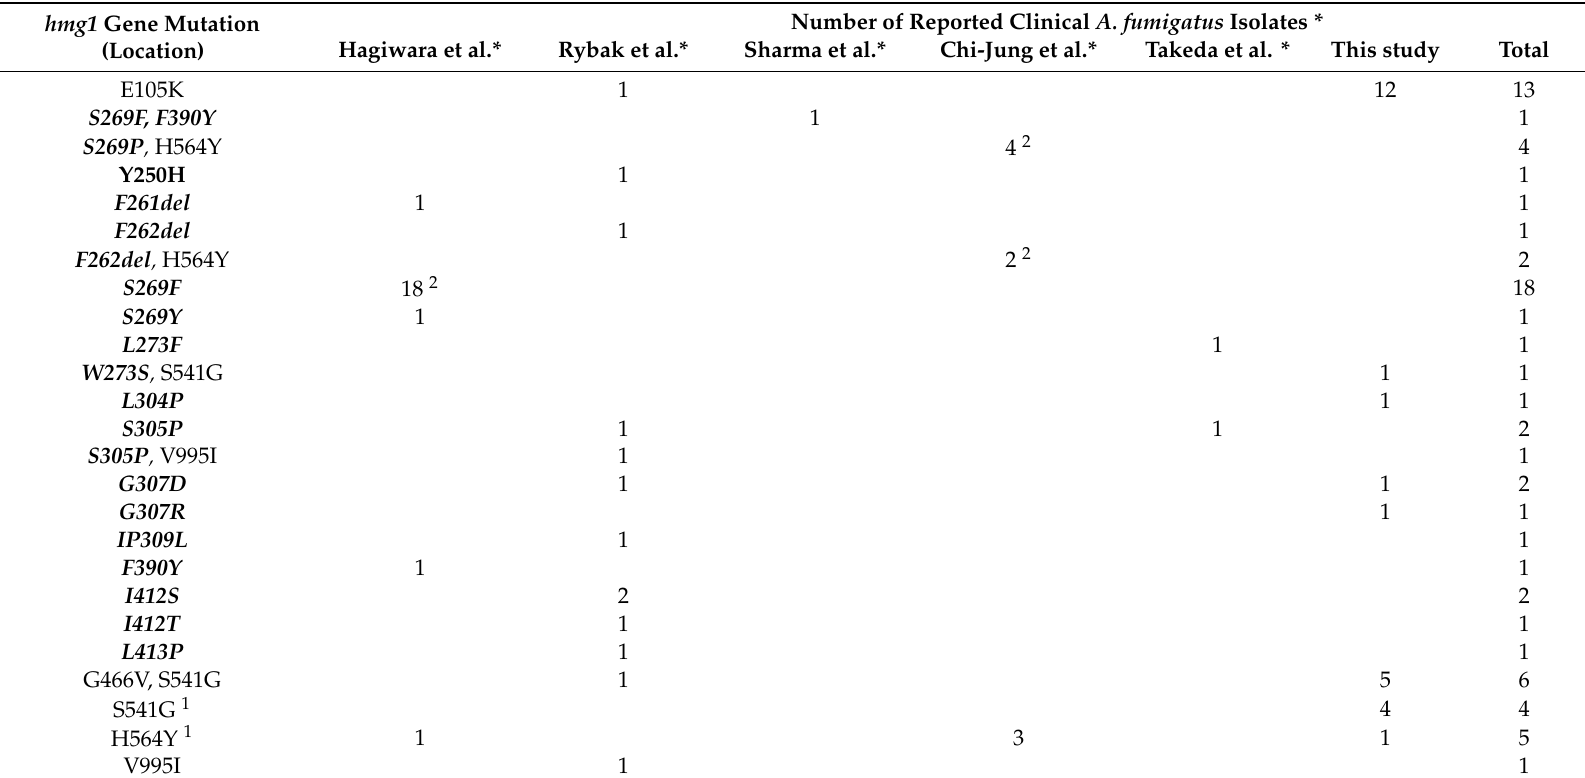
Table 2. Reported Clinical Aspergillus fumigatus Isolates with Mutations in the hmg1